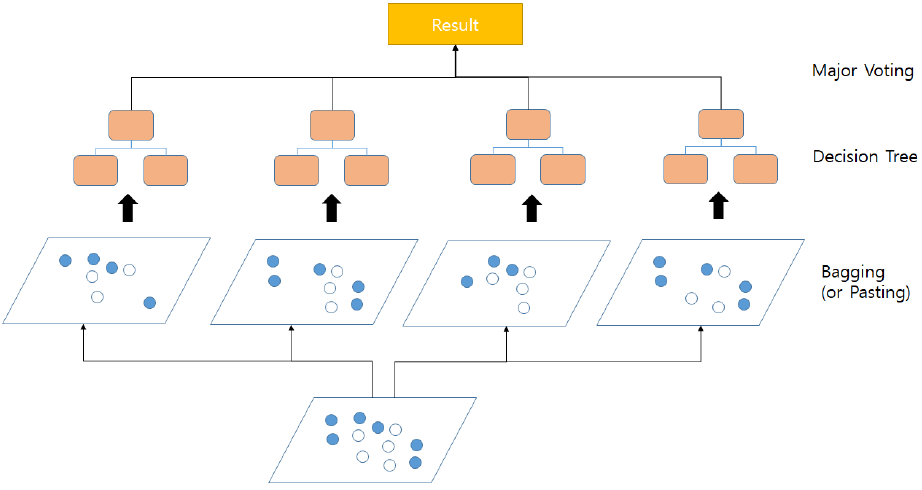
Figure A2. Structure of random